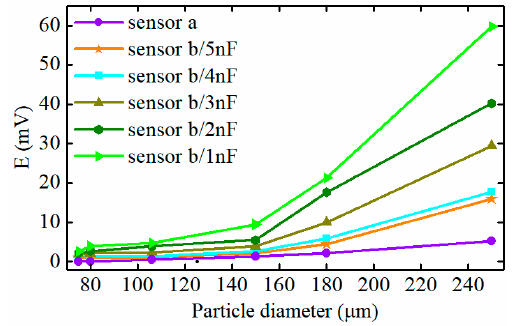
Figure 13. The comparison analysis of sensor sensitivity.